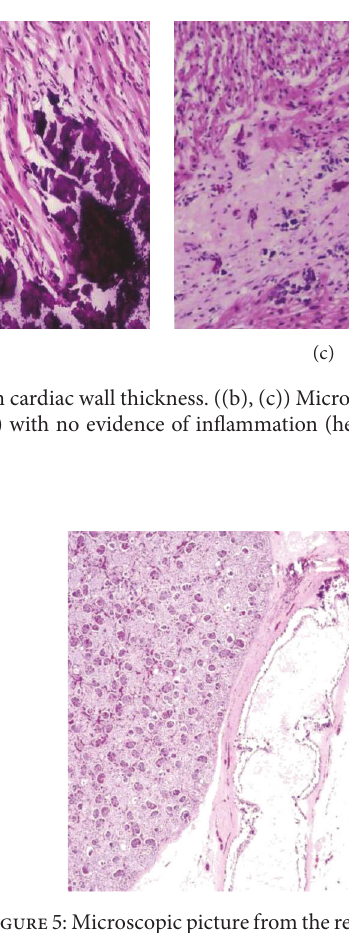
Figure 5: Microscopic picture from the renal hilum shows extensive calcium deposition involving internal elastic lamina with ingrowth of loose fibromyxoid tissue resulting in luminal narrowing and obstruction (hematoxylin-eosin, original magnification ×